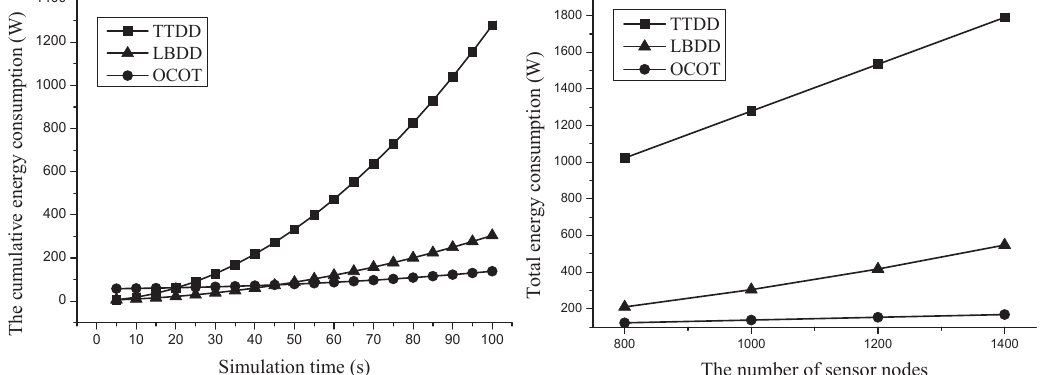
Figure 15. Comparison of total energy consumption according to simulation time ( left ) and the number of sensor nodes ( right